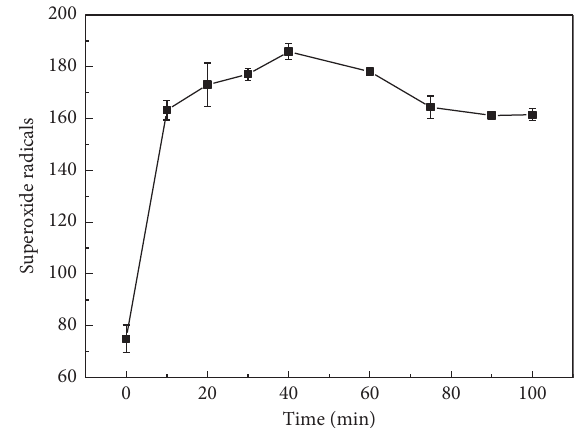
Figure 5: The effect of ultrasonic time on superoxide radicals.